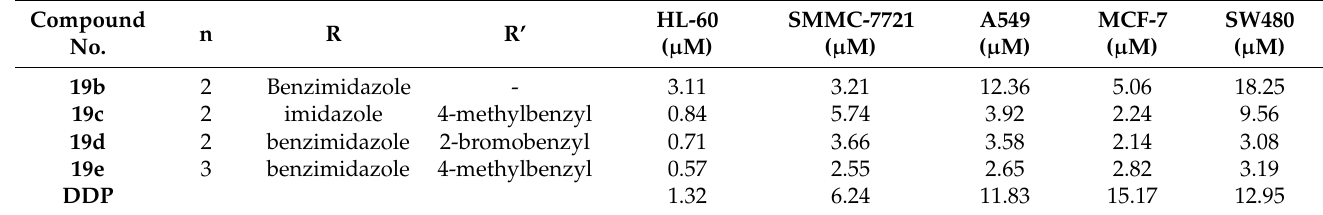
and evaluated its anticancer activity against various cell lines including A549, NCI-H1299